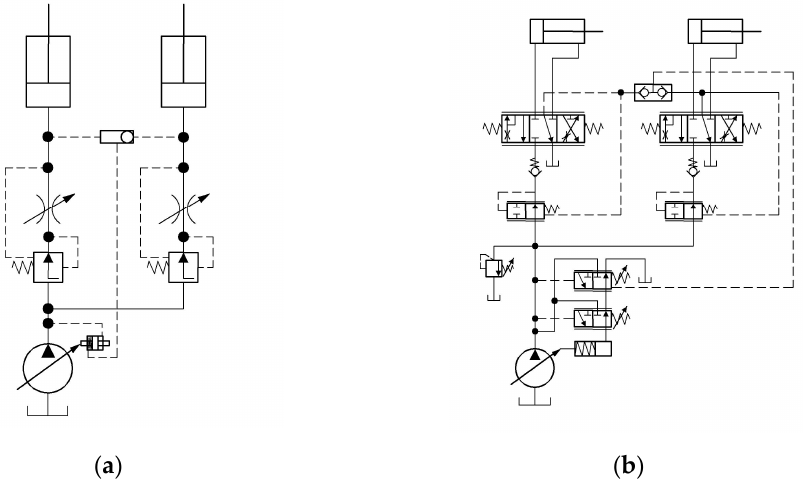
Figure 7. LS System. ( a ) Structure of diagram LS system. ( b ) Schematic diagram of LUDV system.